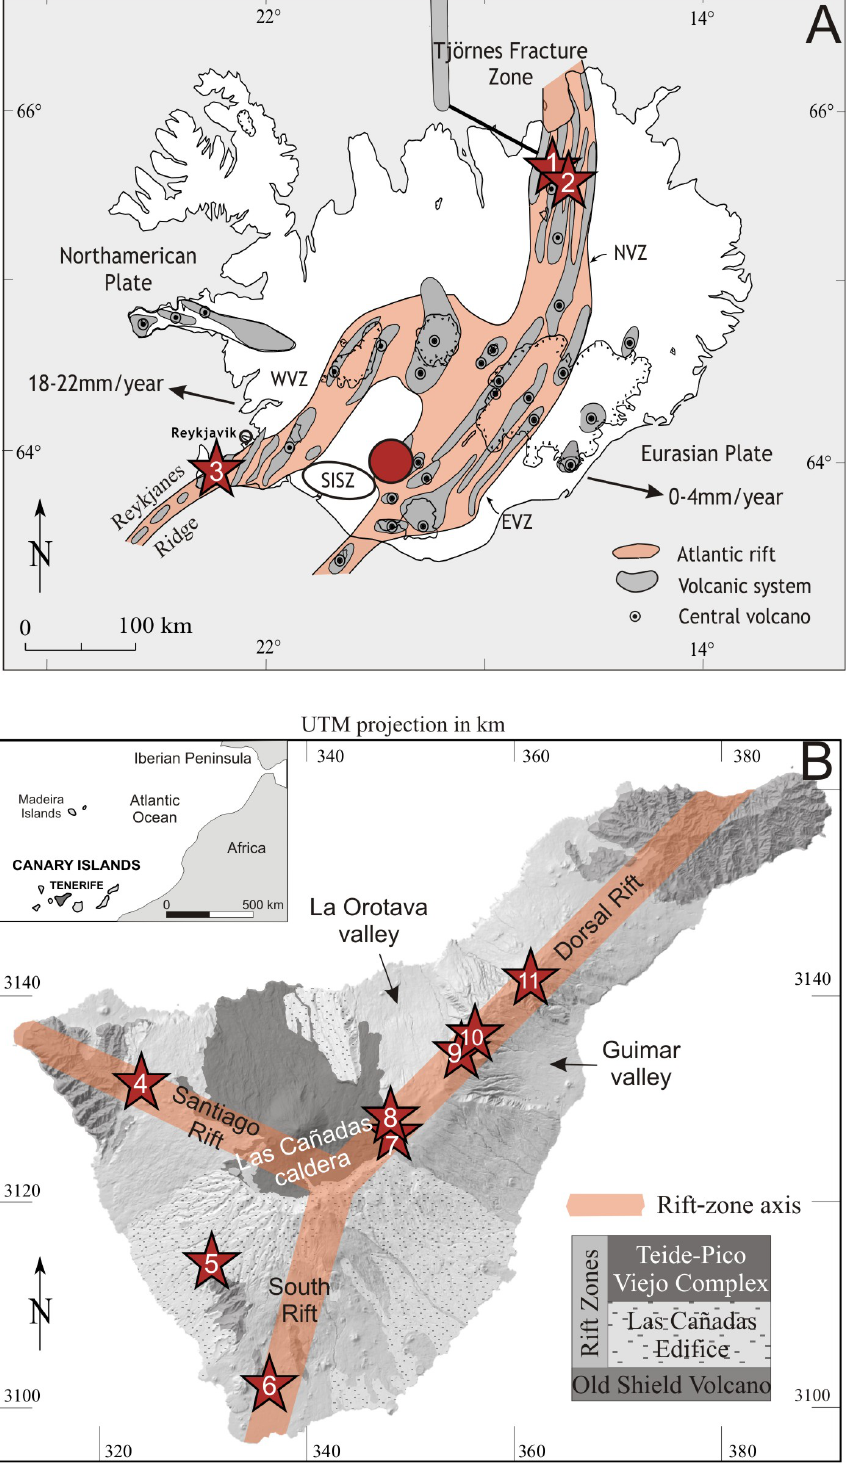
Fig. 2. Simplified geological maps of Iceland (A) and Tenerife (B) showing the location of the active rift zones (in orange) and the studied feeder dykes (red stars). The numbers indicate the name of the feeder dykes: (1) Hljodaklettar; (2) Raudholar; (3) Reykjanes; (4) Llanos; (5) Infierno; (6) Cho; (7) Colmenas; (8) Chiqueros; (9) Negrita; (10) Colorada; (11) Chese. Also shown is the location of the Hekla Volcano (red filled circle), the 1991 volcanic eruption (and associated feeder dyke) of which are analysed in the paper. The inset map in (B) shows the location of the Tenerife